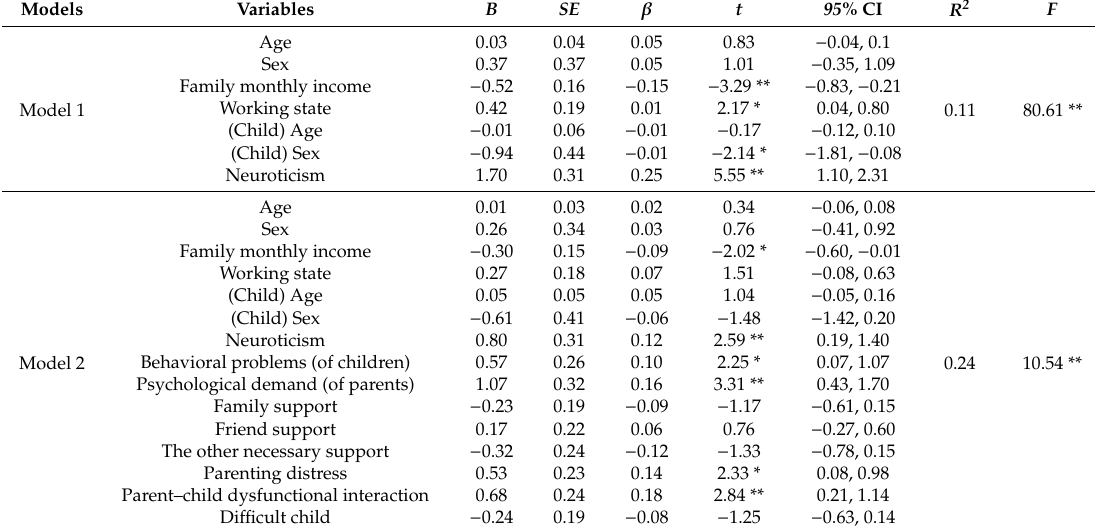
Table 2. Hierarchical linear regression analysis among parents of children with autism spectrum